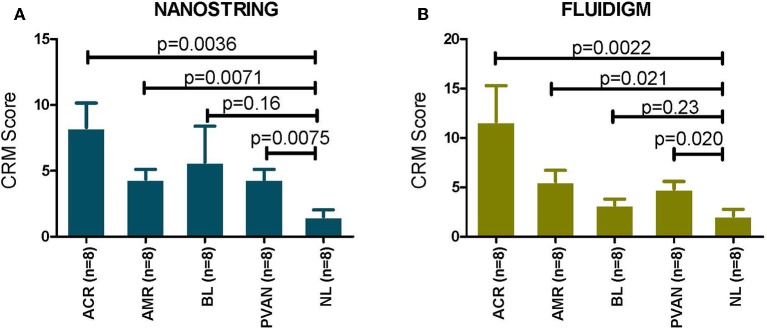
CRM scores are significantly increased in transplant injury. CRM score was used to evaluate difference among different transplant injury phenotypes. (A) The CRM scores calculated from the NanoString (barcoded oligos) data for injury phenotypes (TCMR, AMR, PVAN) were significantly higher than the CRM scores for NL phenotypes (p ≤ 0.05). (B) The CRM scores calculated from the QPCR data for injury phenotypes (TCMR, AMR, PVAN) were significantly higher than the CRM scores for NL phenotypes (p ≤ 0.05). Even though there was a trend of higher CRM scores for borderline changes (BL), they were not significant (p > 0.05) for both platforms.